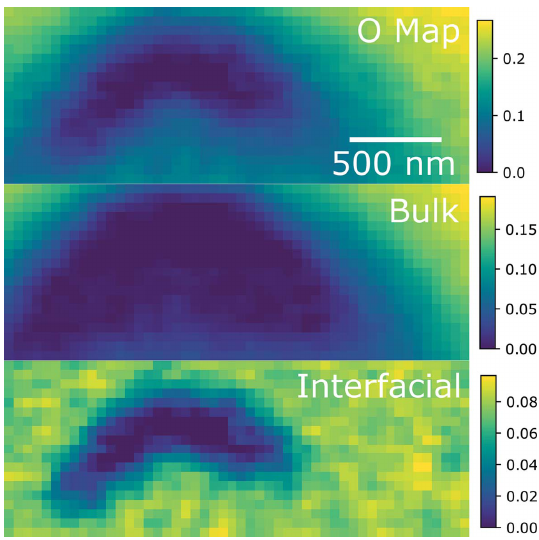
Figure 4 (Top) An oxygen map, and (middle) bulk and (bottom) interfacial species maps of FIB section 1B near the defect in the sample generated by the FIB. Note the separate scale for each map, where the values are normalized to the oxygen edge step (proportional to the total oxygen content in each phase). The STXM pixel size is 50 nm (cid:3) 50